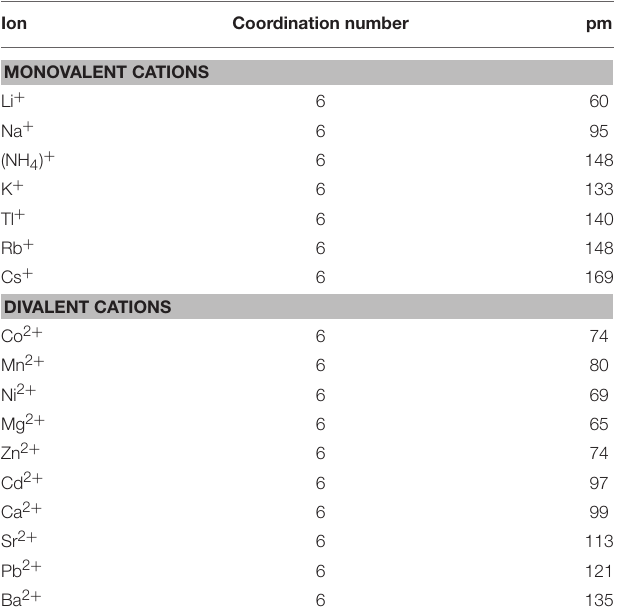
TABLE 1 | List of the effective ionic radii of the cations interacting with GQs Cotton and Wilkinson (1980). Ion Coordination number